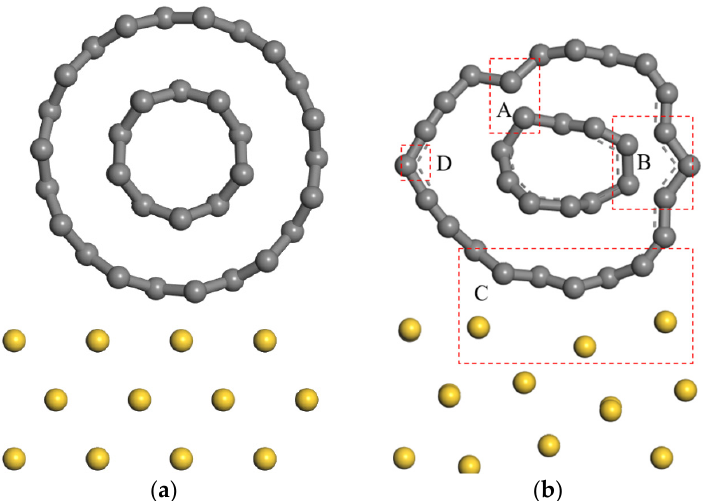
Figure 12. Interface contact configuration of DWCNT and gold slab ( a ) before optimization; ( b ) after optimization.